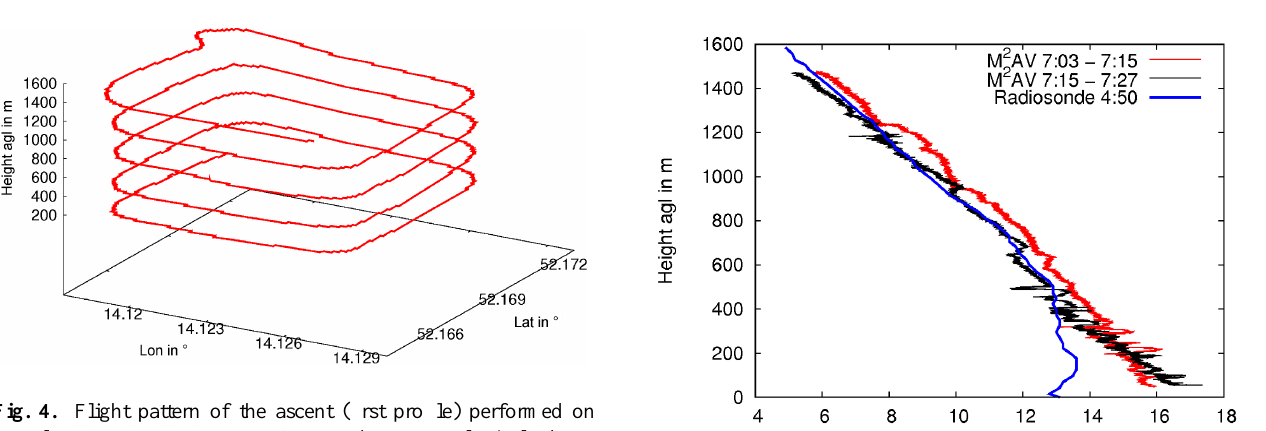
Fig. 4. Flight pattern of the ascent (first profile) performed on 21 July 2009, 07:03–07:15 UTC, near the Meteorological Obser- vatory Lindenberg – Richard-Aßmann-Observatory.